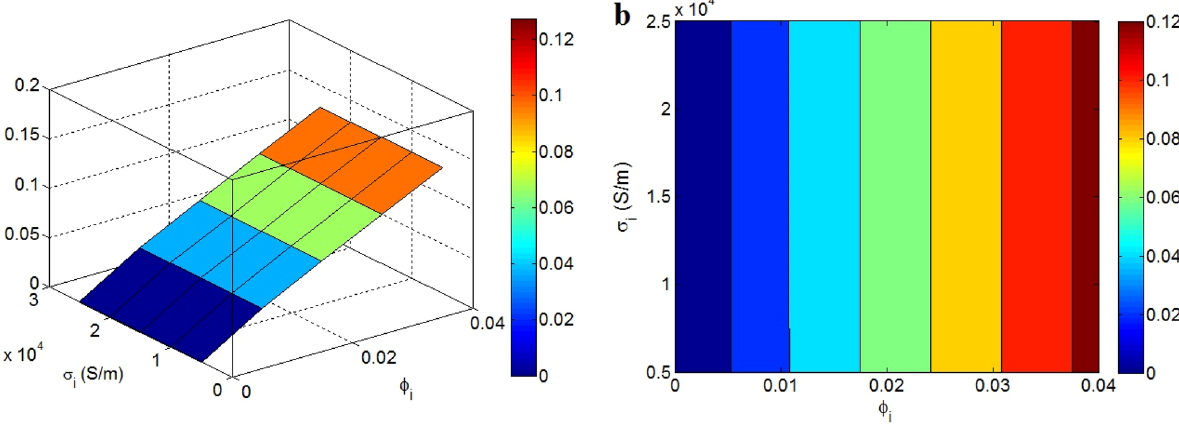
Figure 7. Illustration of efficient conductivity at countless points of “ ϕ i ” and “σ i ”: ( a ) 3D and ( b ) contour